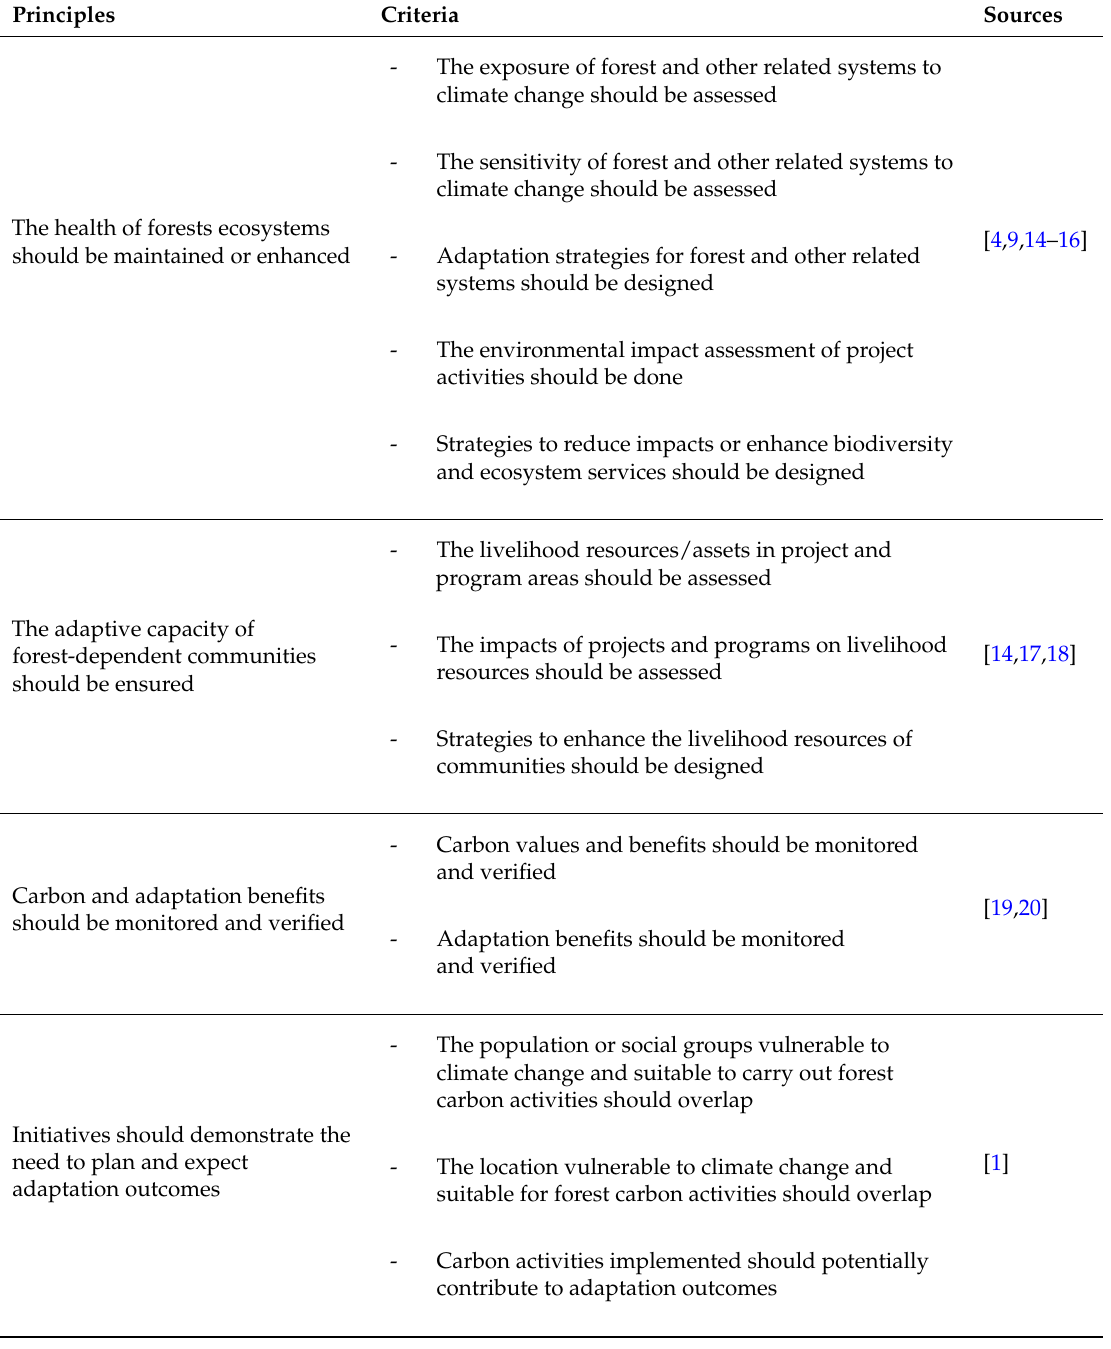
Table 1. Principles and criteria for guiding the integration of adaptation goals in forest carbon